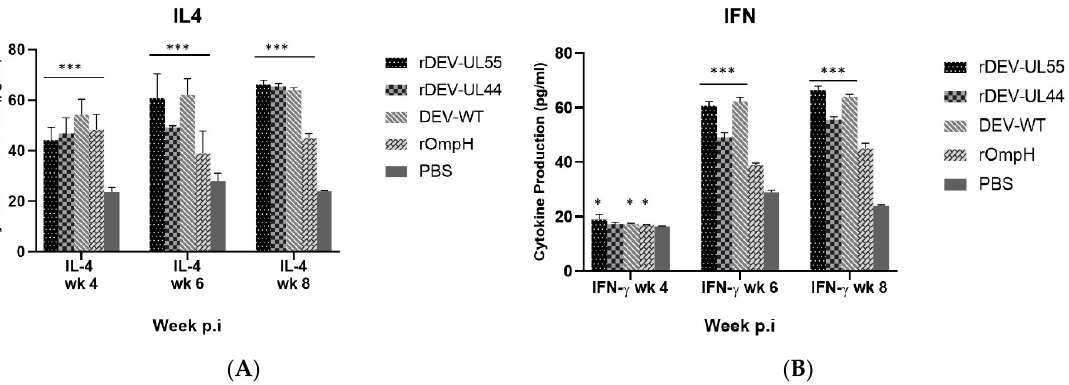
Figure 4. Cellular response to rDEV ‐ UL55 & rDEV ‐ UL44 vaccination. Serum IL ‐ 4 ( A ) and IFN ‐γ ( B ) cytokine levels in ducks were assessed before challenge at 4, 6, and 8 weeks post ‐ immunization. Statistically significant differences are indicated by (***) p < 0.001, (**) p < 0.01, and (*) p < 0.05 compared with the PBS control.